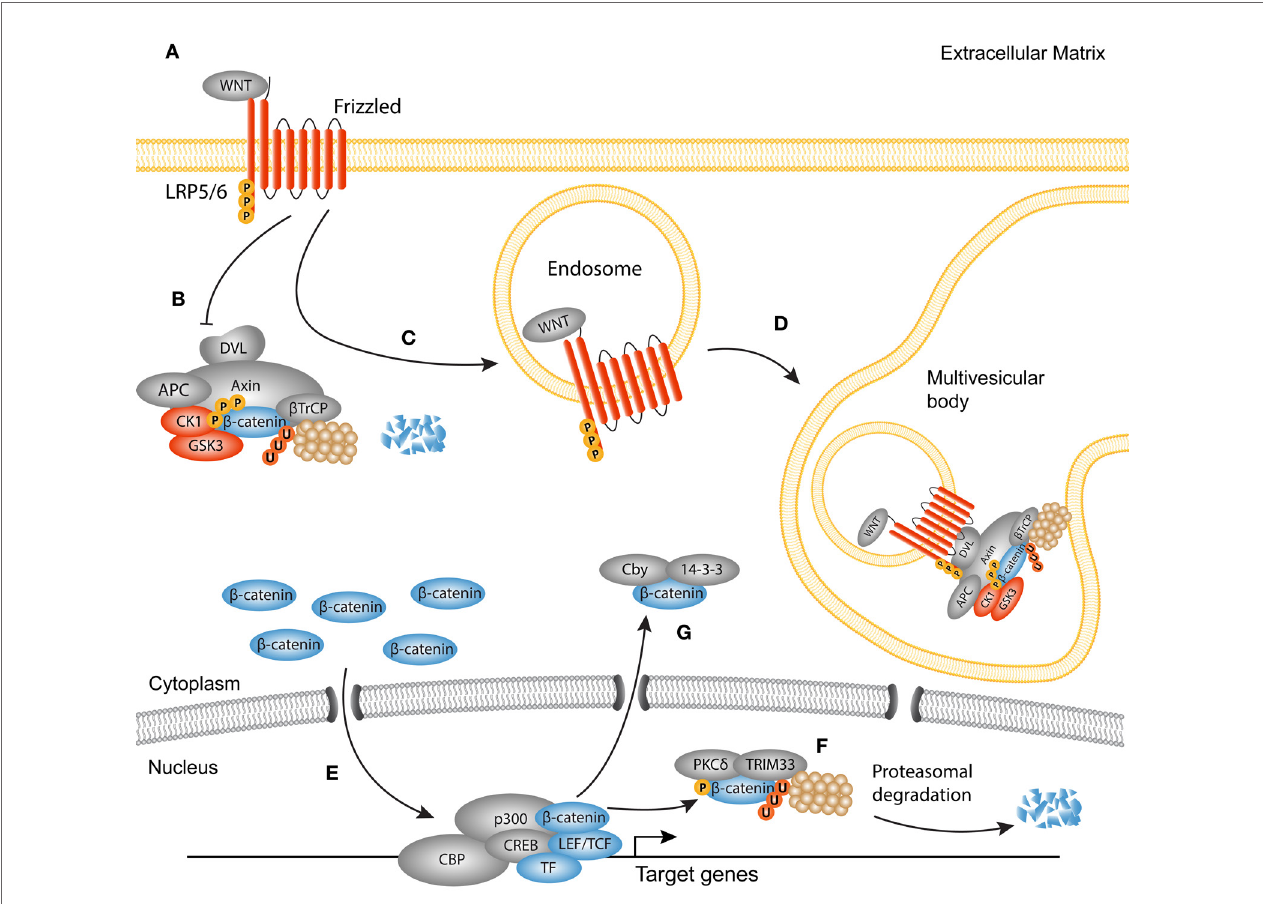
multivesicular bodies where it cannot interact with cytoplasmic β -catenin, and thus protects β -catenin from proteasomal degradation. (e) Newly synthesized β -catenin translocates to the nucleus to interact with LEF/TCF transcription factors and other co-factors, such as p300 and CBP. (F) Termination of the WNT/ β -catenin signaling cycle may occur through phosphorylation of β -catenin by protein kinase C (PKC) δ and subsequent ubiquitination by tripartite motif (TRIM)33. These steps target β -catenin for proteasomal degradation in the nucleus. (G) Another possible route for the termination of β -catenin activation is the cytoplasmic sequestering by 14-3-3 ζ and Chibby